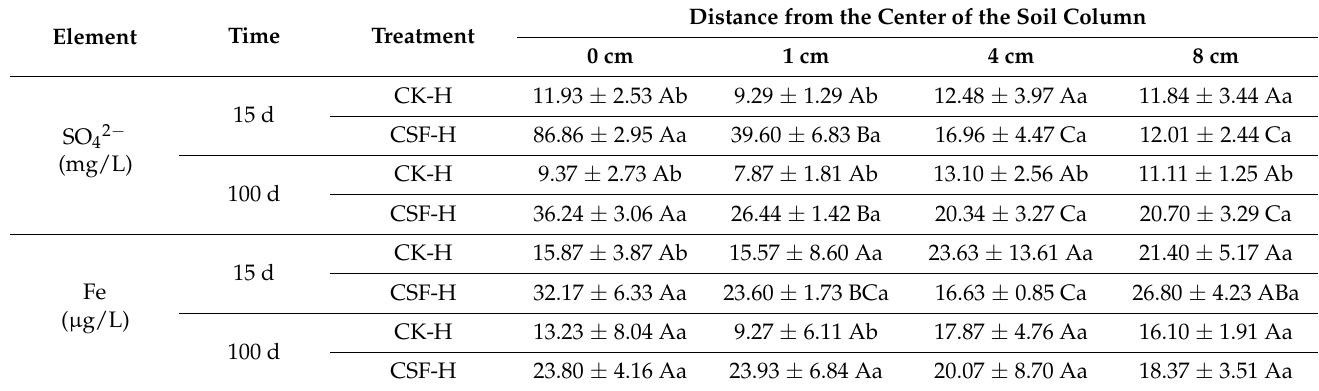
Table 4. The concentrations of SO 42 − and total Fe in different horizontal soil layers with CSF